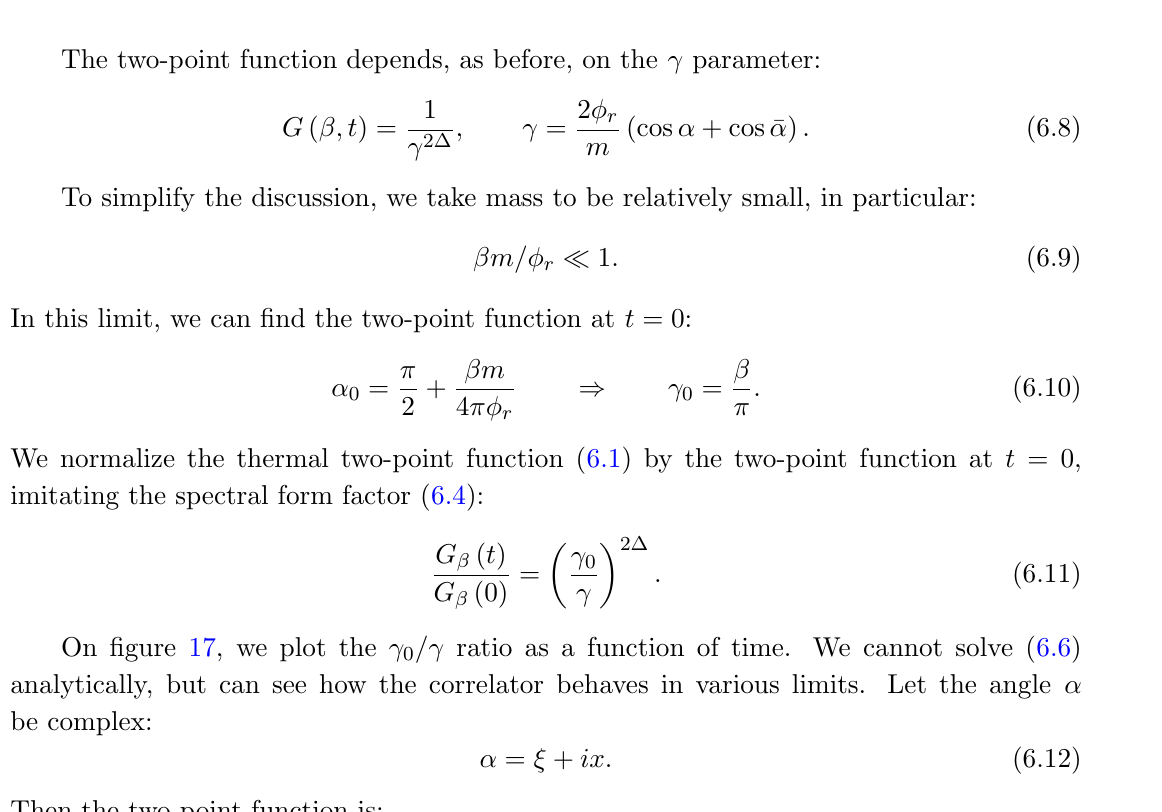
Figure 17 . Two-point function in real time without the extrinsic curvature